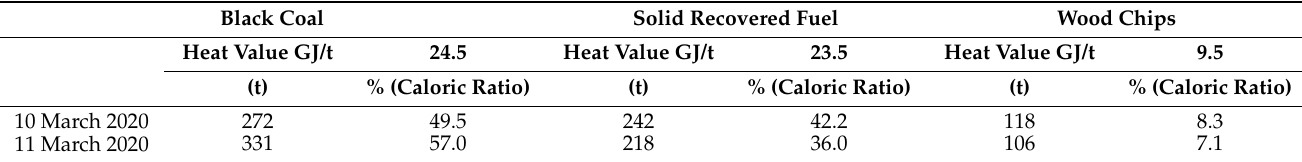
Table 4. Quantities and proportions of fuels during the